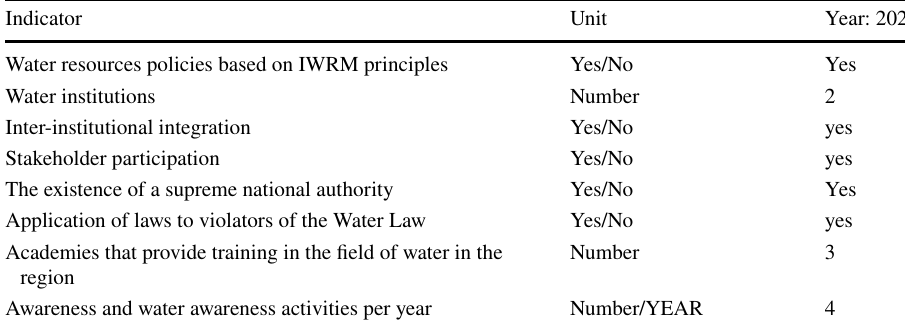
environmental indicators and institutional arrangement